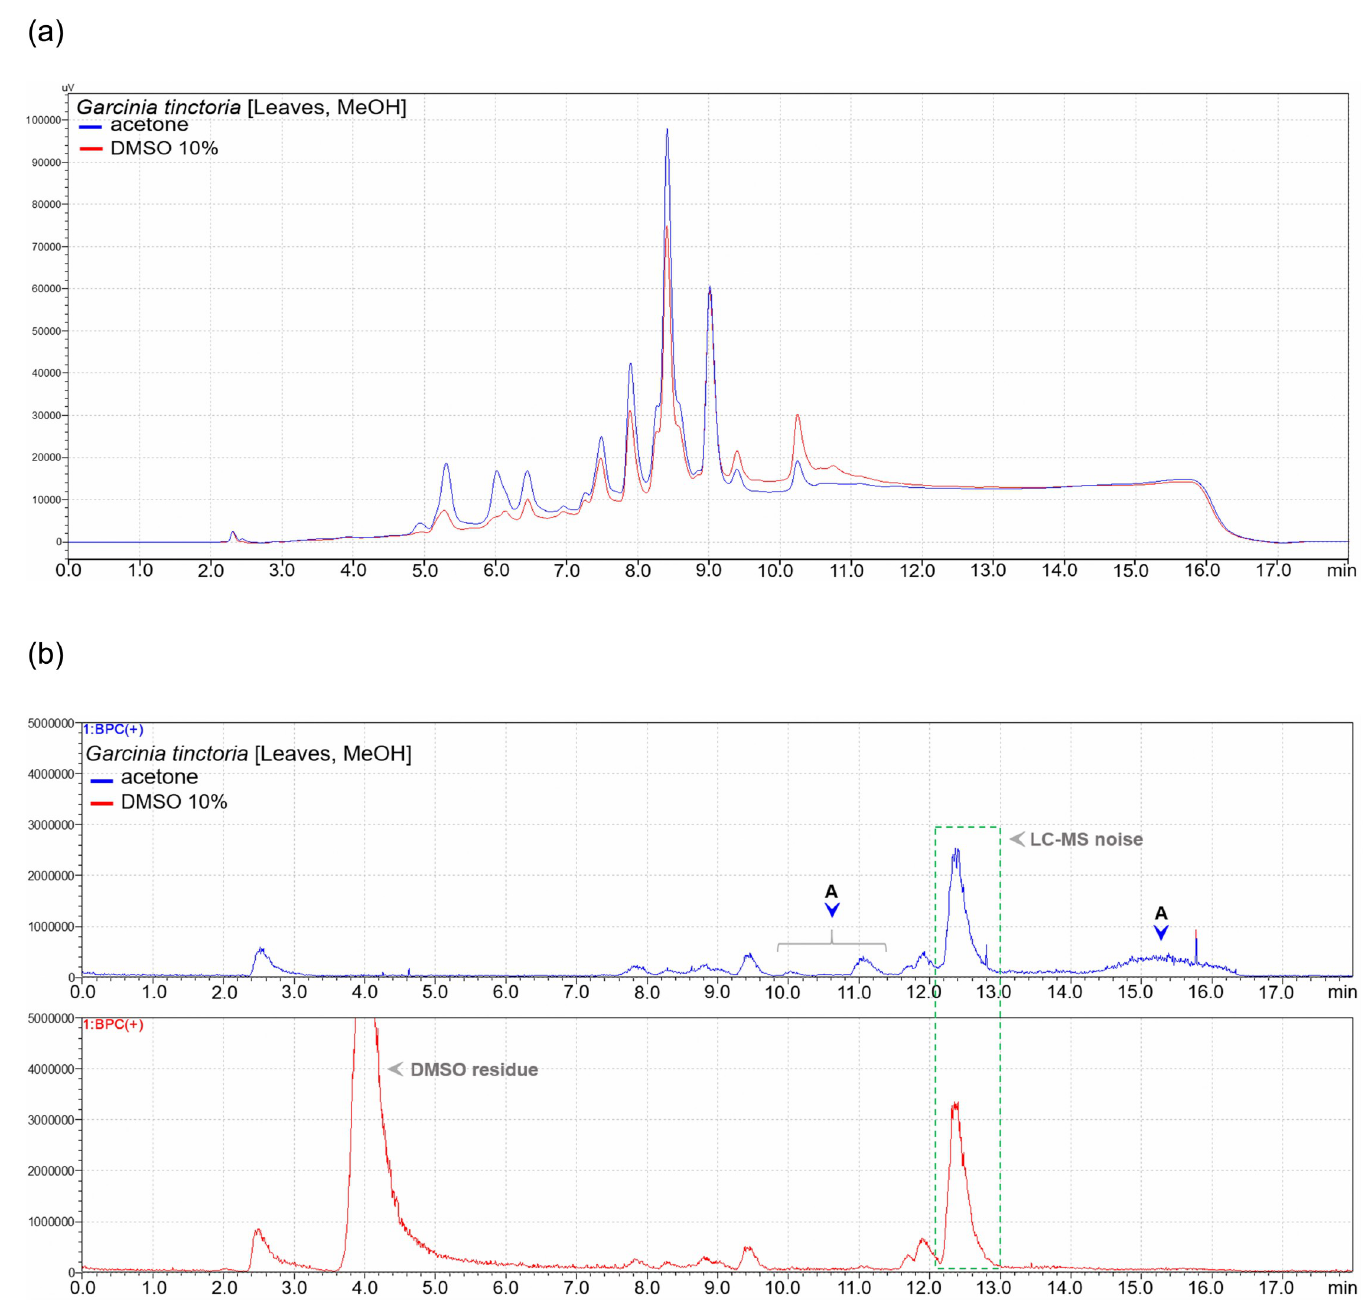
Fig 2. a . An overlay of UV chromatograms of acetone (blue) and DMSO (red) based working solutions of a methanol leaves extract of G . tinctoria , which had better solubility in acetone. Higher quantities of phytochemicals are observed in the acetone based working solution towards a less polar region of the chromatogram. b . Comparison of base peak chromatograms of acetone (blue) and DMSO (red) based working solutions of a methanol leaves extract of G . tinctoria , which had a better solubility in acetone. At least three additional compounds (marked A) are visible in the less polar region of acetone based working solution’s